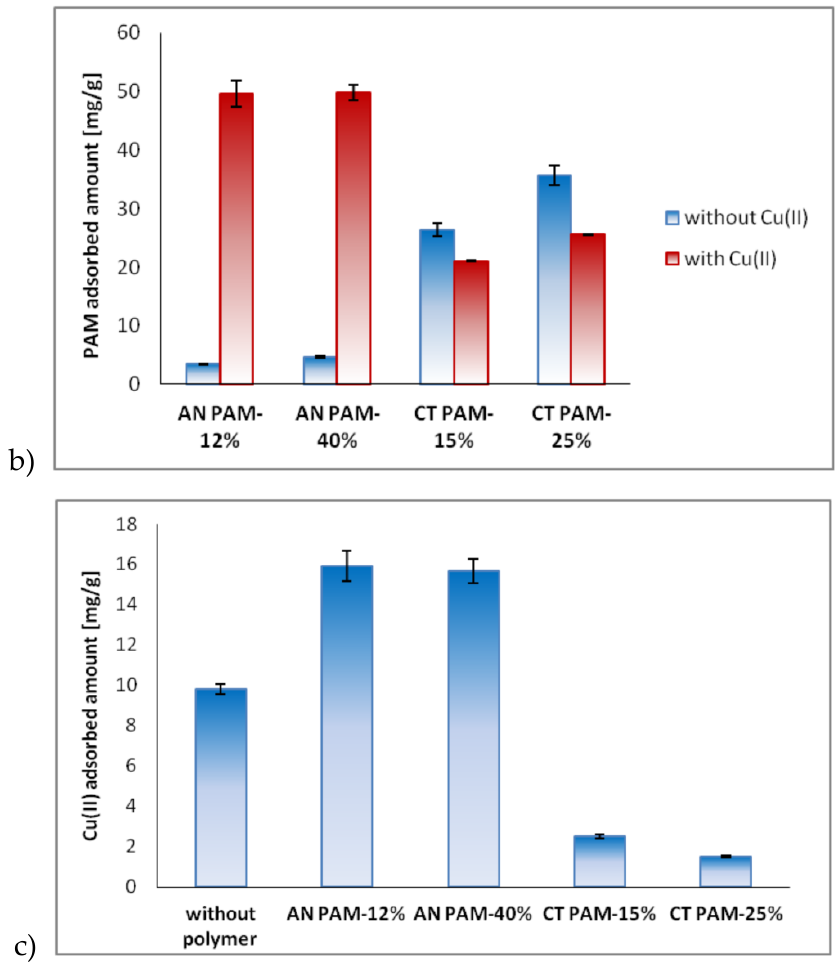
Figure 5. Ionic polyacrylamide and copper(II) ions adsorbed amounts on C-SiO 2 in the single systems (the initial concentration of adsorbates was 50 or 100 ppm) ( a ) or mixed PAM / Cu(II) systems (the initial concentration of adsorbates was 100 ppm) ( b , c ) at pH 6.